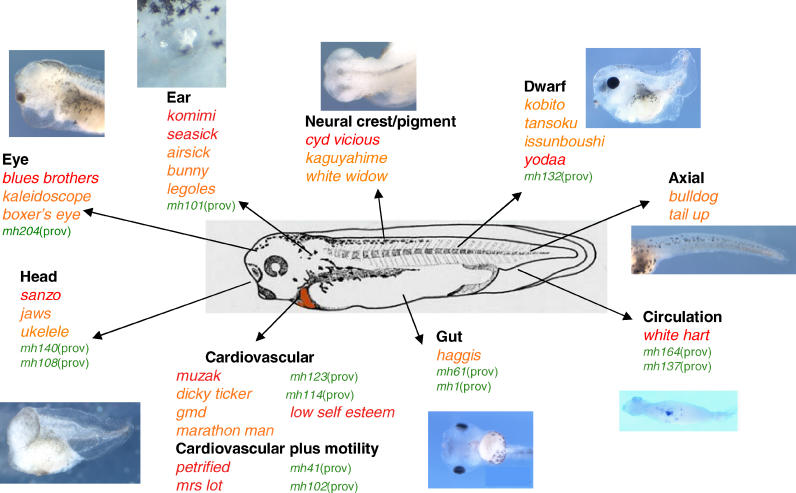
Phenotypes DetectedDefects were sorted into ten broad categories (shown with representative images): eye (zatoichi), inner ear and otolith (komimi), neural crest/pigment (cyd vicious), dwarf (issunboushi), axial (bulldog), circulation (desert tad), gut (haggis), cardiovascular system and motility, and head (troll). Color code (green, orange, red) is described in Figure 1 and used in Tables 2 and 3 to denote current confirmation status of individual mutations in the pipeline. Provisional alleles (“prov,” green) have not yet been assayed for heritability.